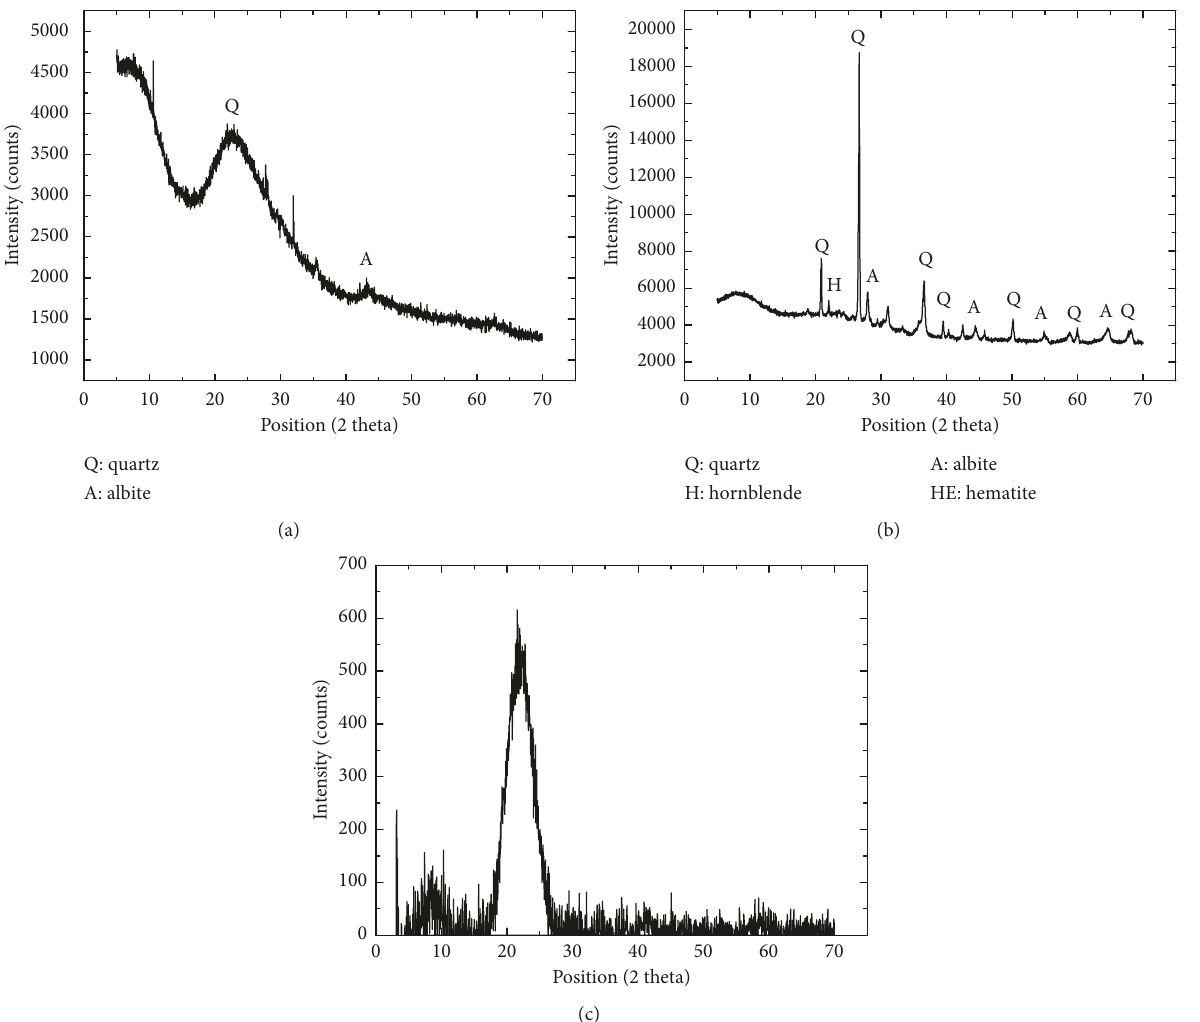
Figure 1: XRD patterns of (a) LWA perlite, (b) LWA aliven, and (c)